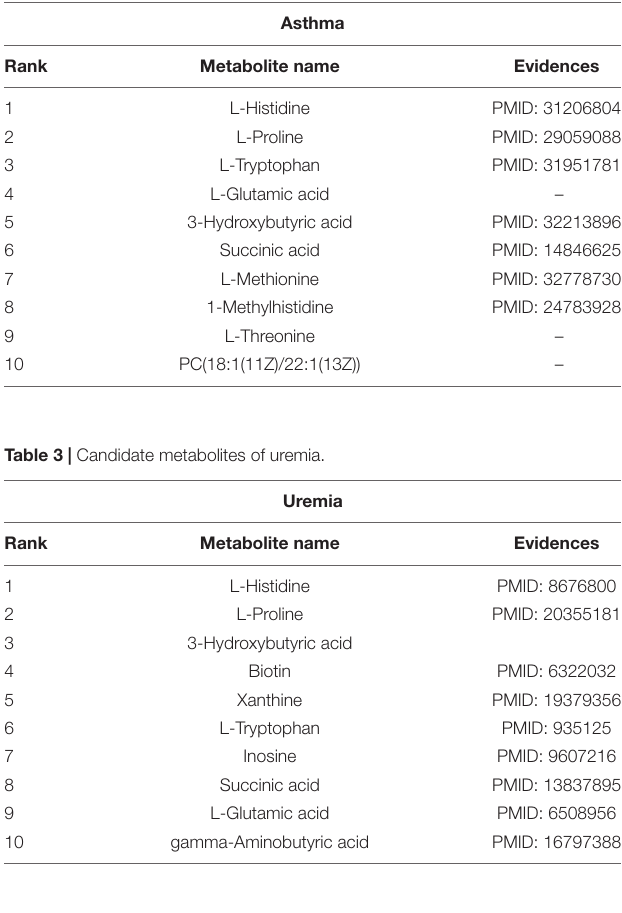
Table 2 | Candidate metabolites of asthma.